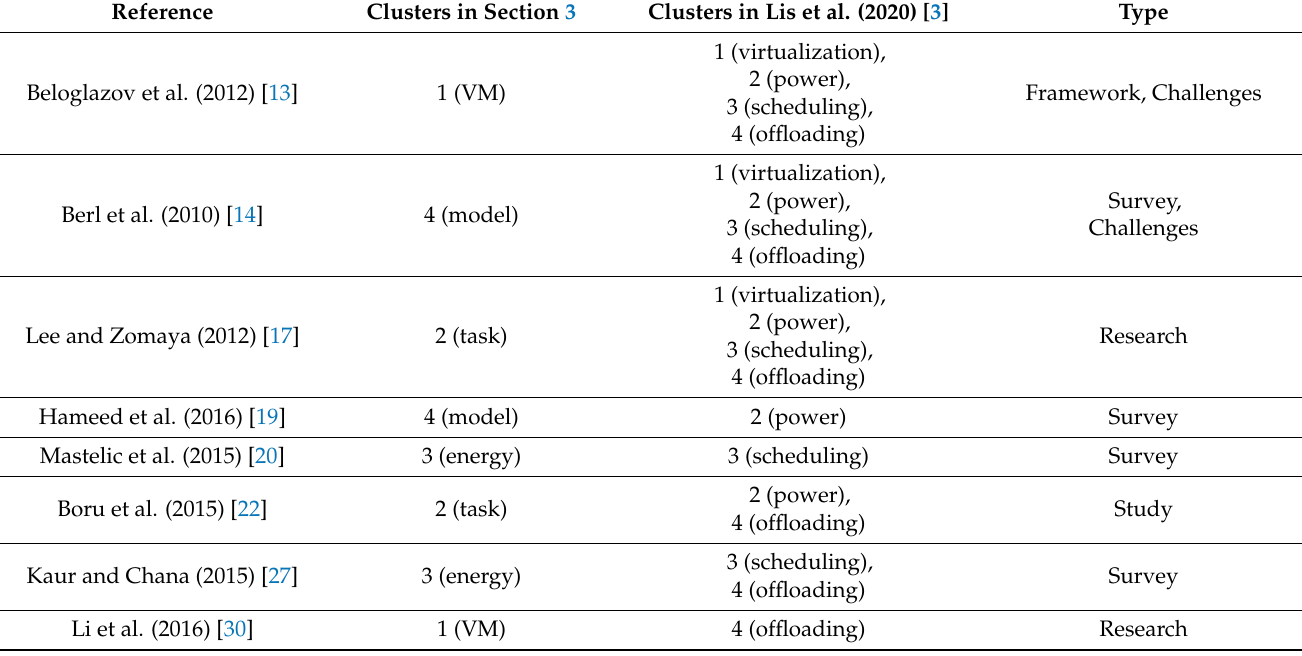
Table 5. References present in clusters identified both in Section 3 and in Lis et al. (2020) [3].